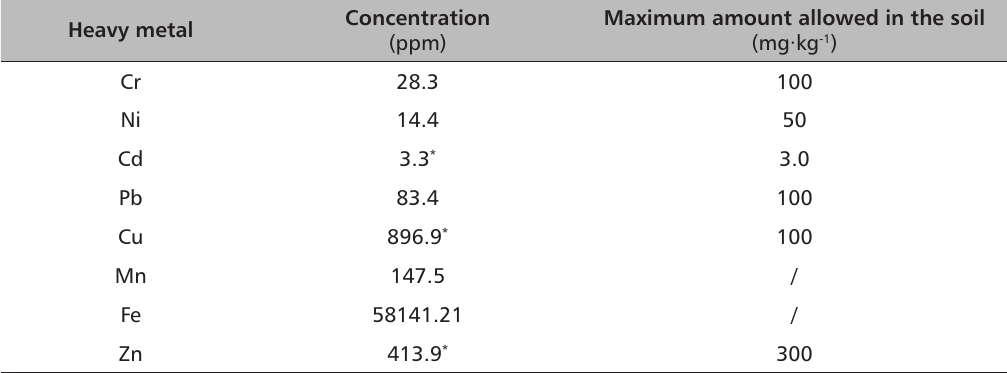
* Values higher than maximum allowed by National